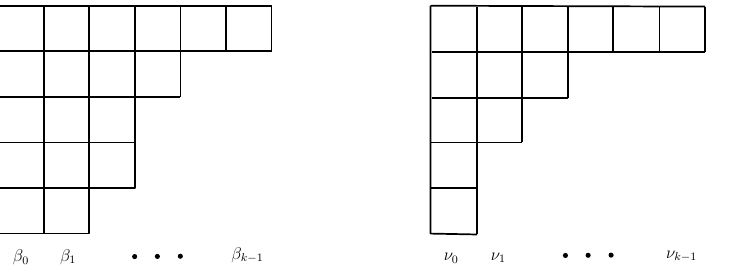
Figure 8 . Hanany-Witten like brane set-up equivalent to the brane configuration in figure 5.